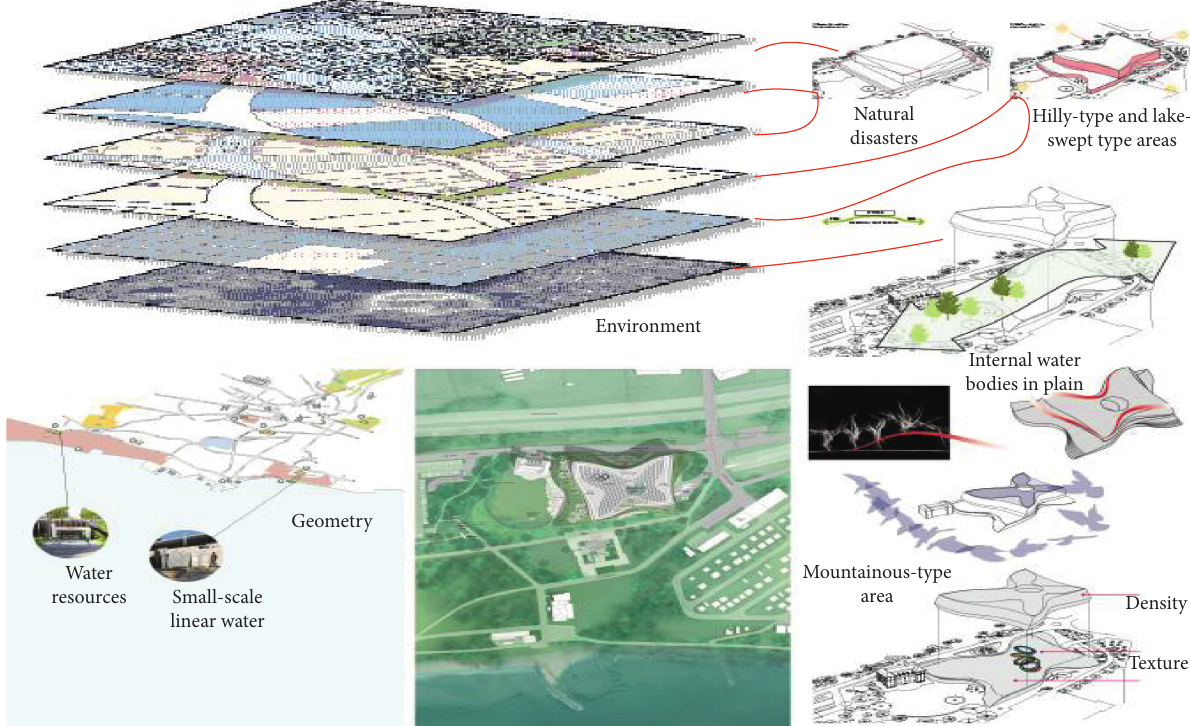
Figure 2: Spatial distribution characteristics of the urban